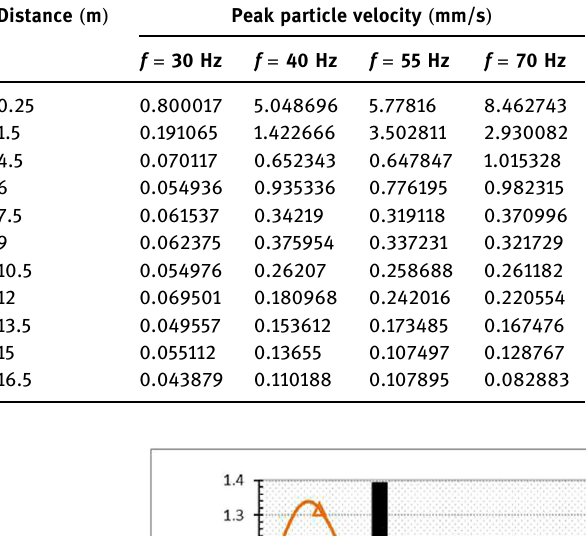
Table 9: The measured peak particle velocities at di ff erent locations for various frequencies ( active in - fi lled with 30% rubber trench barrier ) Distance ( m )